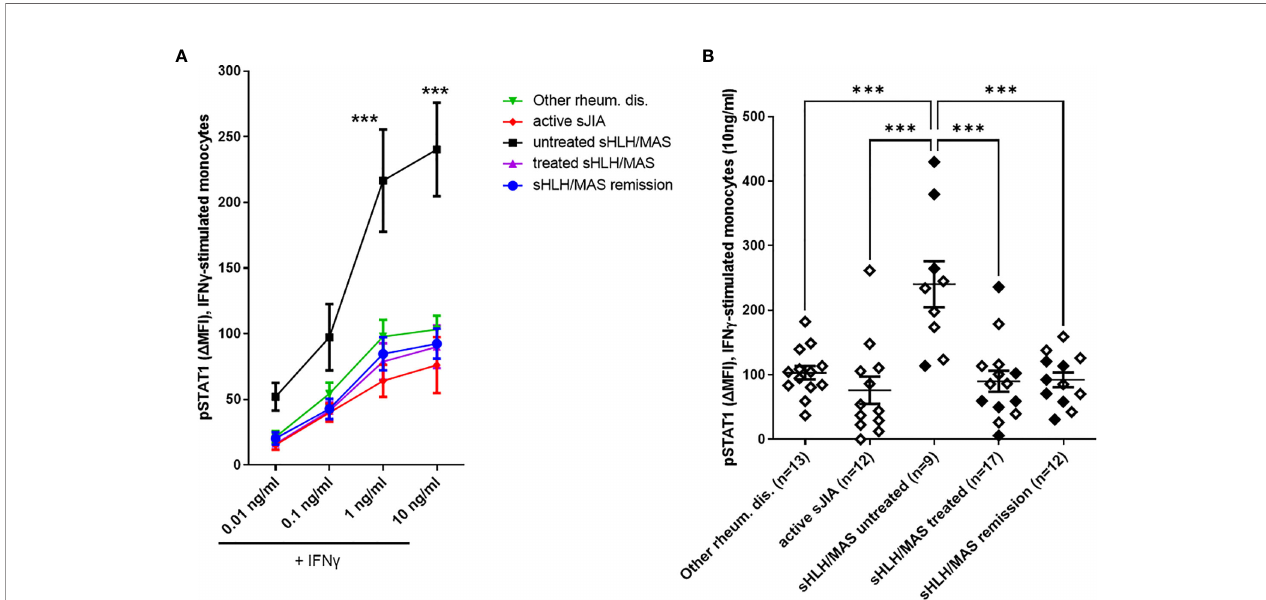
FIGURE 2 | Monocytes from untreated MAS/sHLH patients show increased responsiveness to IFN g . (A) pSTAT1 levels were evaluated in monocytes from patients following ex vivo stimulation with increasing concentration of human recombinant IFN g . Differences between groups were analyzed using the two-way ANOVA test and the post hoc Bonferroni ’ s for multiple comparisons test. The data shown represent mean ( ± SEM) values; *** p ≤ 0.001. In untreated sHLH/MAS patients, pSTAT1 levels following stimulation with 1 and 10 ng/ml of IFN g were signi fi cantly higher than those observed in all the other patient groups (p < 0.0001). (B) pSTAT1 levels in monocytes stimulated with 10 ng/ml of IFN g are reported in detail. Full diamonds indicate samples from MAS patients. (A, B) pSTAT1 levels were measured by fl ow cytometry and reported as Delta mean fl uorescence intensity ( D MFI, calculated by subtracting MFI values of isotype controls from sample MFI values). Untreated sHLH/MAS patients were 9 instead of 10, because for one patient there were not enough cells for IFN g -stimulation